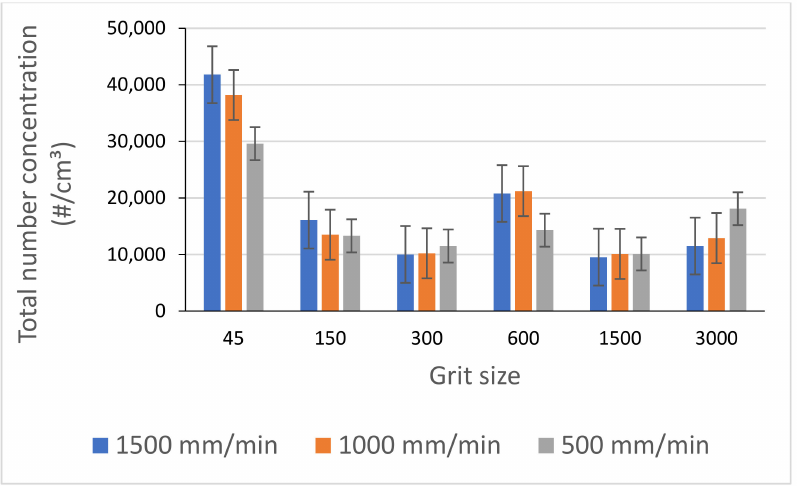
Figure 11. Total number concentration of FP while grinding black granite for different grit sizes (Vs = 2500